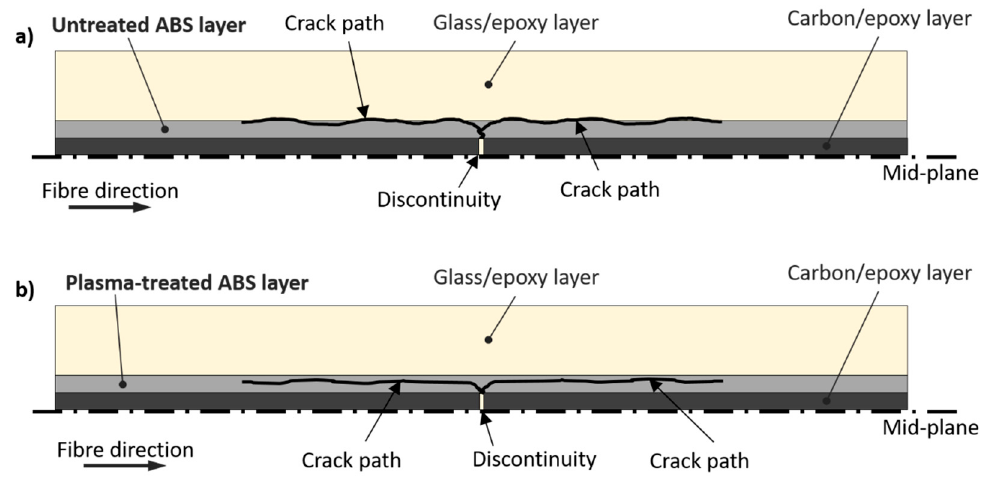
Figure 11. Representation of the crack path in ABS-interleaved hybrid composites ( a ) with untreated ABS ( b ) with plasma-treated ABS.